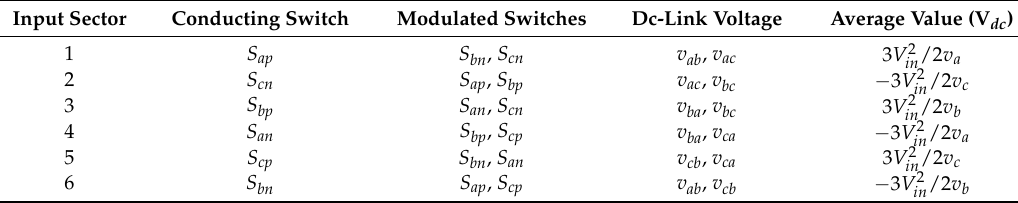
Table 1. The switching states and their DC-link voltages according to the input sector. Input Sector